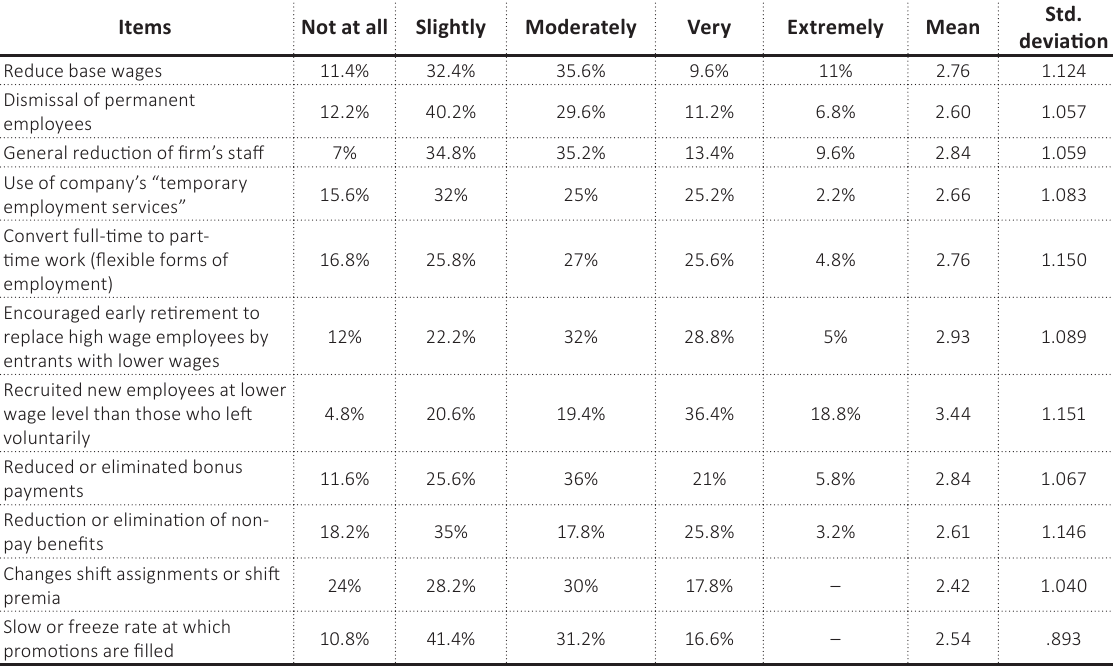
Table 7. Descriptive statistics for the strategies that firms select to reduce labor costs